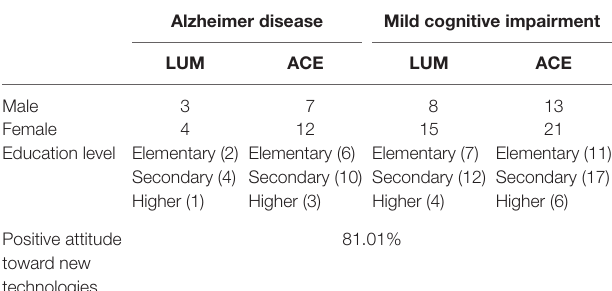
Table 2 | brief characteristic of the group of cognitive impairment